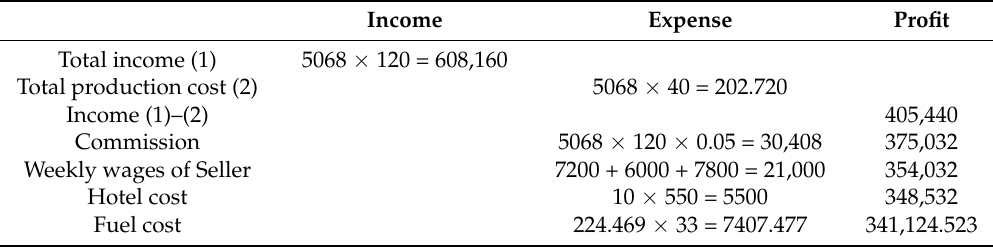
Table 5. Total profit calculation in Thai Baht.